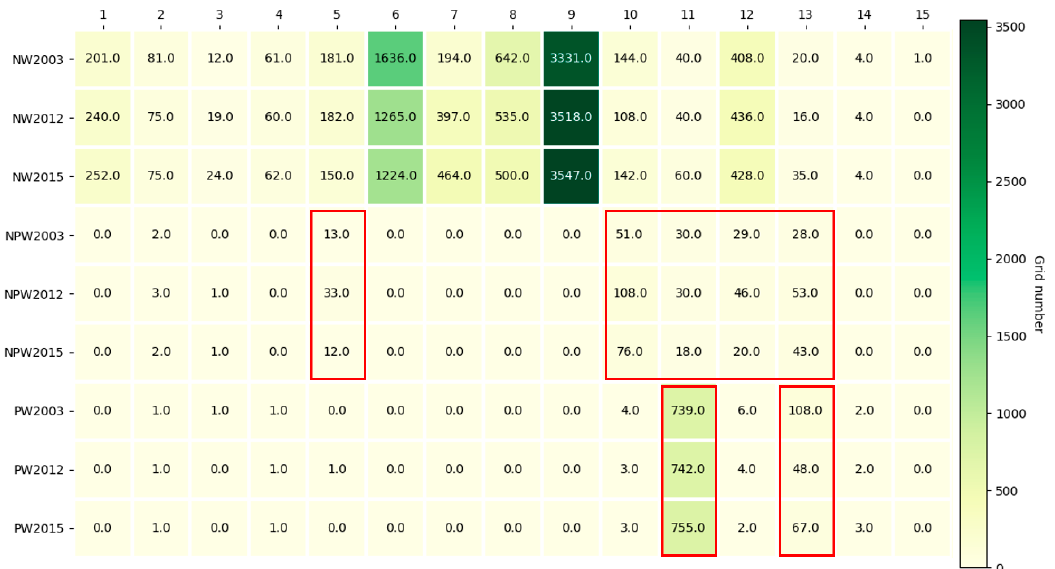
Figure 8. Heatmap of the number of cells having the same relationship of the matchup between LULC types and surface water scenarios for 2003, 2012 and 2015. The x-axis represents the number of di ff erent LULC types, and the y-axis represents the water-related classes in three di ff erent years. Table 7. Average values of water frequency index (WFI) of the NPW class corresponding to di ff erent land use and land cover (LULC) types for 2003, 2012 and